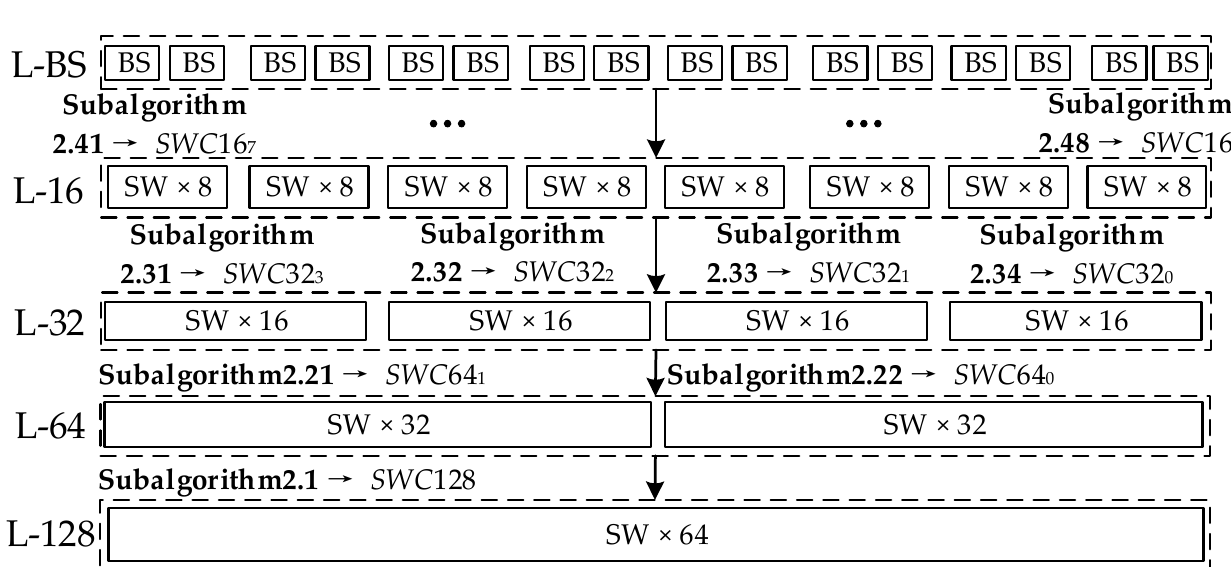
Figure 8. The relationships among the switches, control information, and routing algorithms. Firstly, step 1 checks whether the RSTU works in 128-bit shift mode. If yes, go to step 2. Secondly, steps 2 and 3 use the decoding function DEV and the inverse function INV to